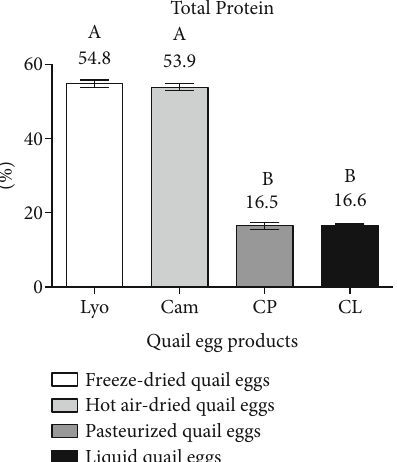
Figure 6: Total protein content of liquid (CL), freeze-dried (Lyo), hot air-dried (Cam), and pasteurized (CP) quail eggs.